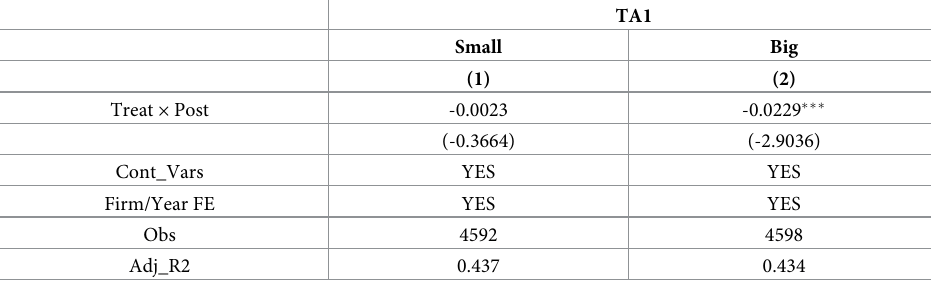
Table 7. Heterogeneity analysis: Firm